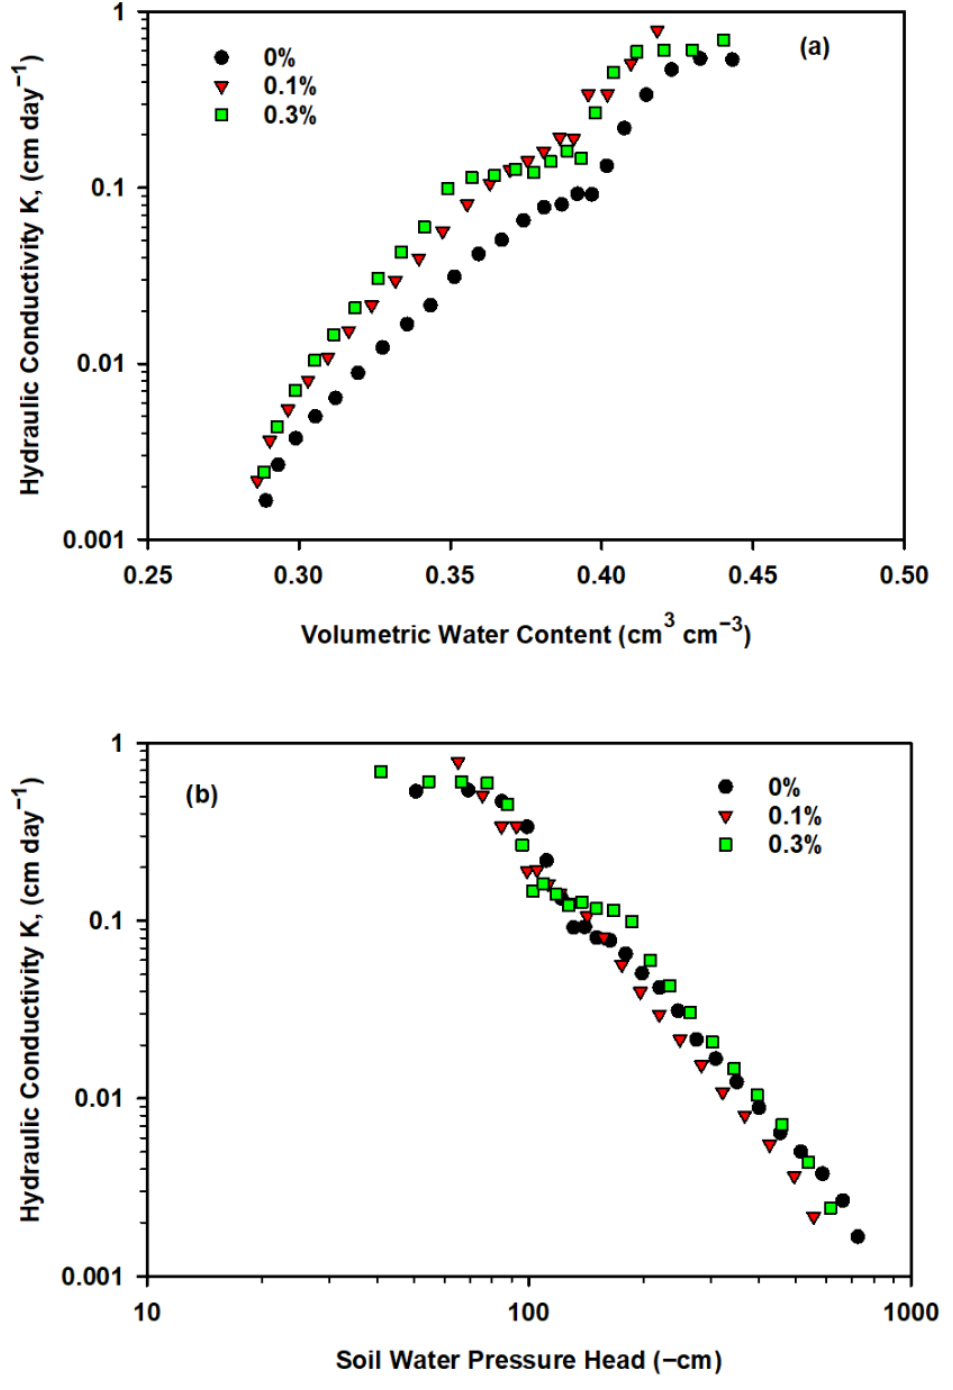
Figure 7. Hydraulic conductivity functions for the silt loam soil when amended with 0, 0.1, and 0.3% ( w / w ) lignin-based hydrogel determined with the evaporation method; ( a ) volumetric water content against hydraulic conductivity K ( θ ), and ( b ) soil water pressure head against hydraulic conductivity K ( h ).